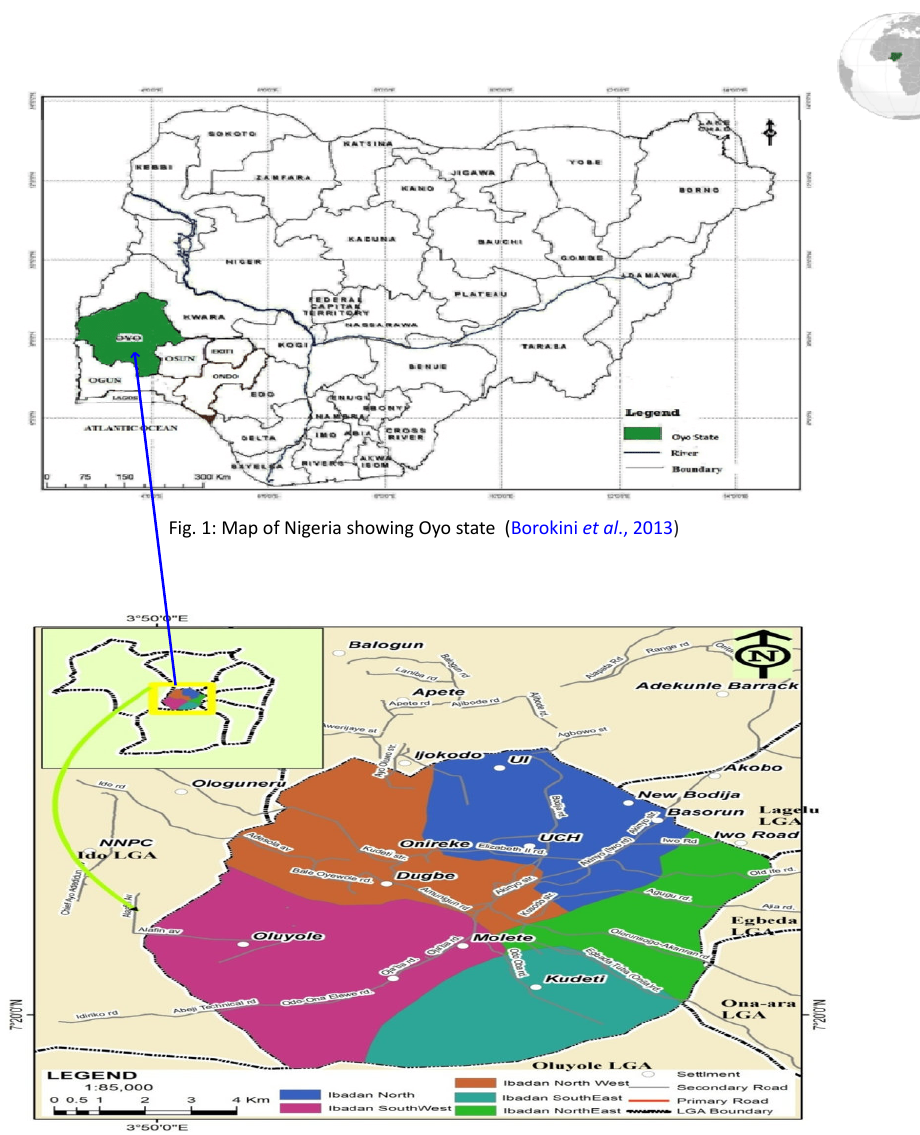
Fig. 2 : Geographic location of the study region in Oyo State, Nigeria